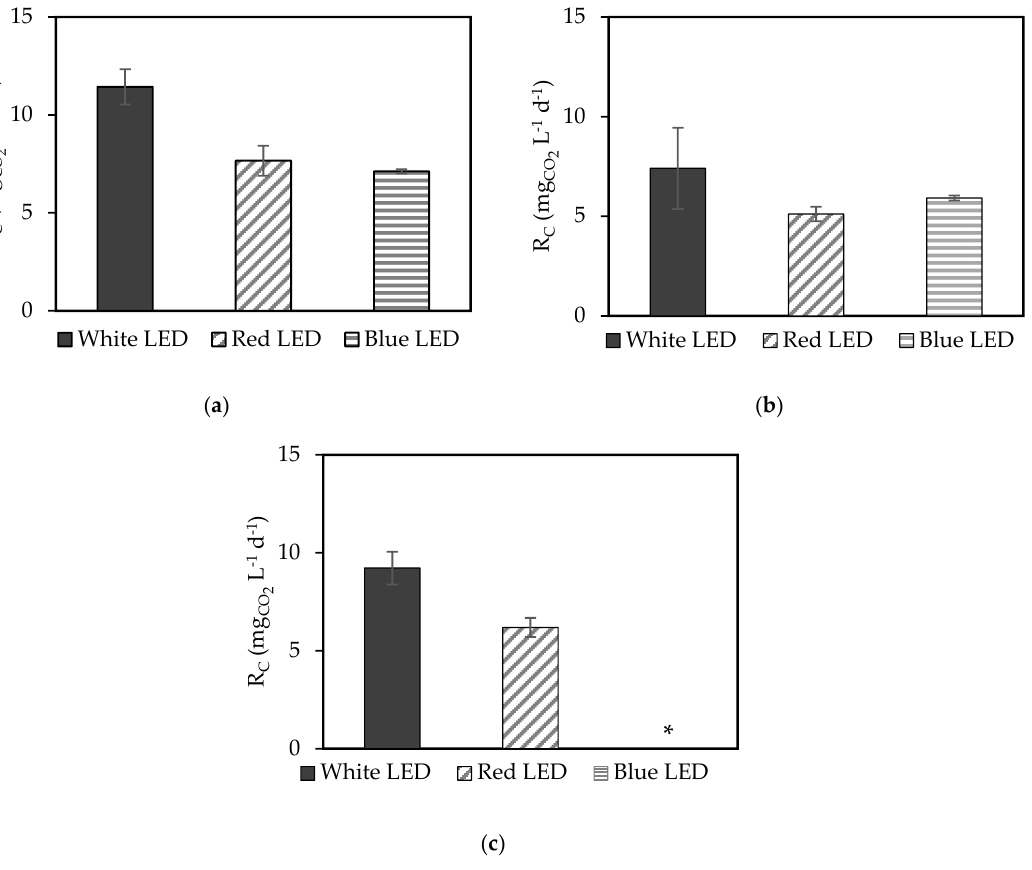
Figure 3. CO 2 fixation rates obtained for ( a ) C. vulgaris , ( b ) T. obliquus and ( c ) N. oleoabundans under different light conditions (white, red and blue LEDs). Error bars correspond to the standard deviation. * Value not determined because this species did not grow under blue light.